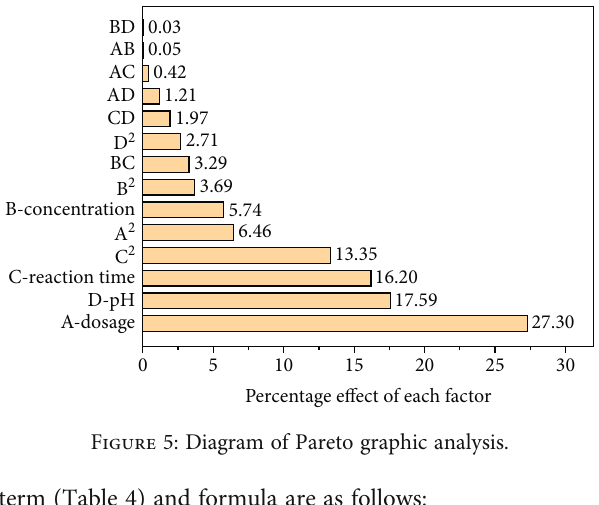
Figure 5: Diagram of Pareto graphic analysis.